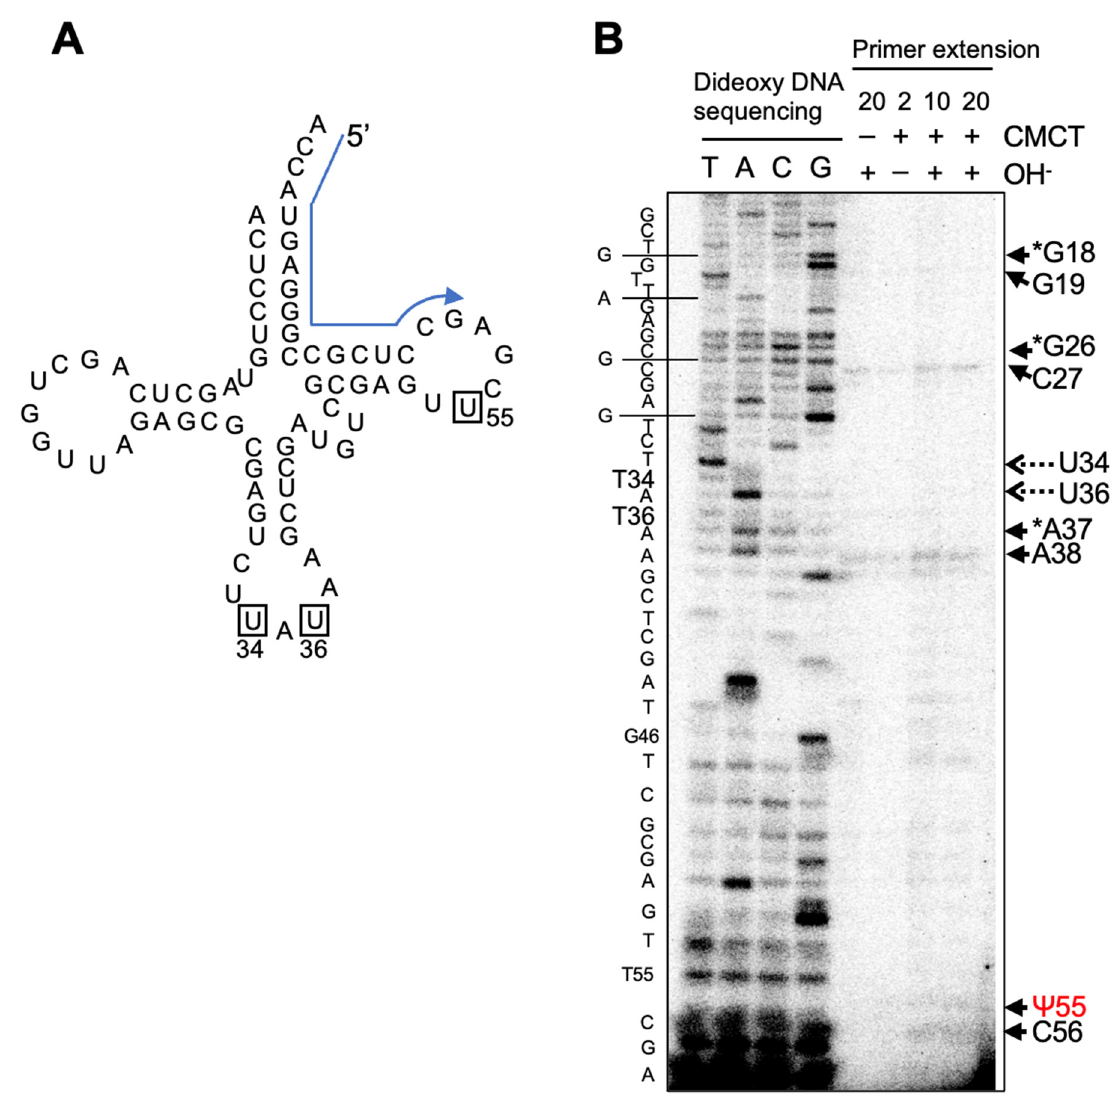
Figure 8. Detection of Ψ modifications in native tRNA Ile (UAU) by CMCT-RT. ( A ) The region com- plementary to a primer used for reverse transcription is marked with a blue arrow on the cloverleaf schematics. ( B ) Primer extensions were performed on class I tRNA from C. merolae . The class I tRNAs were treated with CMCT for 2, 10, and 20 min followed or not by alkaline (OH − ) treatment (+ or − ). Dideoxy DNA sequencing ladders (lanes T,A,C,G) were prepared with the same primers. The positions indicate with dashed arrows are U(T)34 and U(T)36. Black arrows indicate reverse transcription pause positions. Asterisks indicate modified nucleoside s .